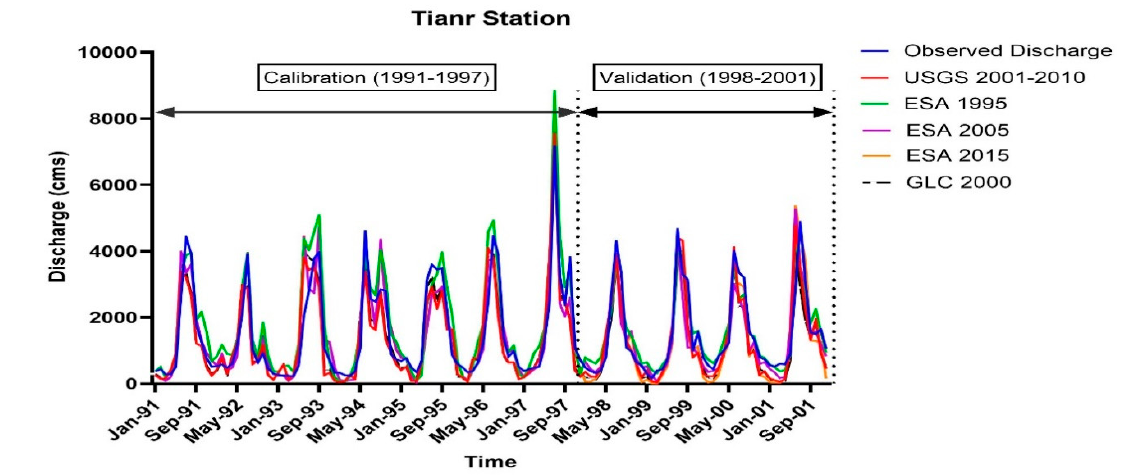
Figure 4. Simulated and observed discharge at Qianjiang Station.